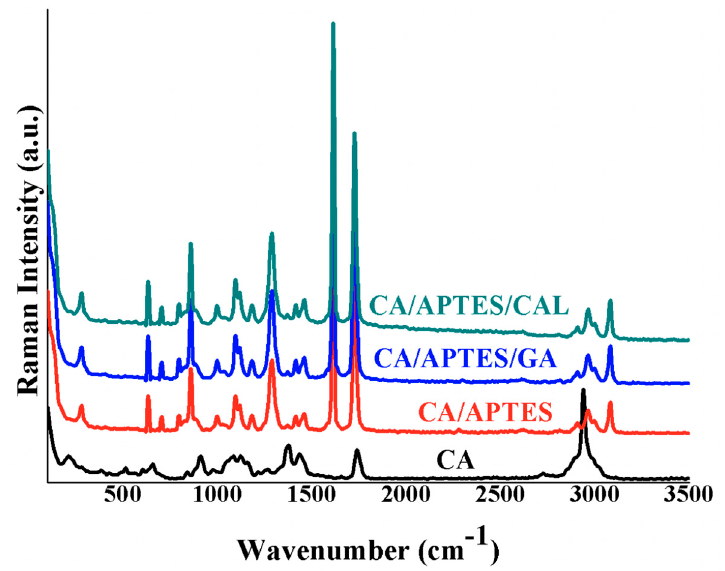
Figure 4. Raman spectra of synthesized CA, CA/APTES, CA/APTES/GA, and CA/APTES/CAL membranes.